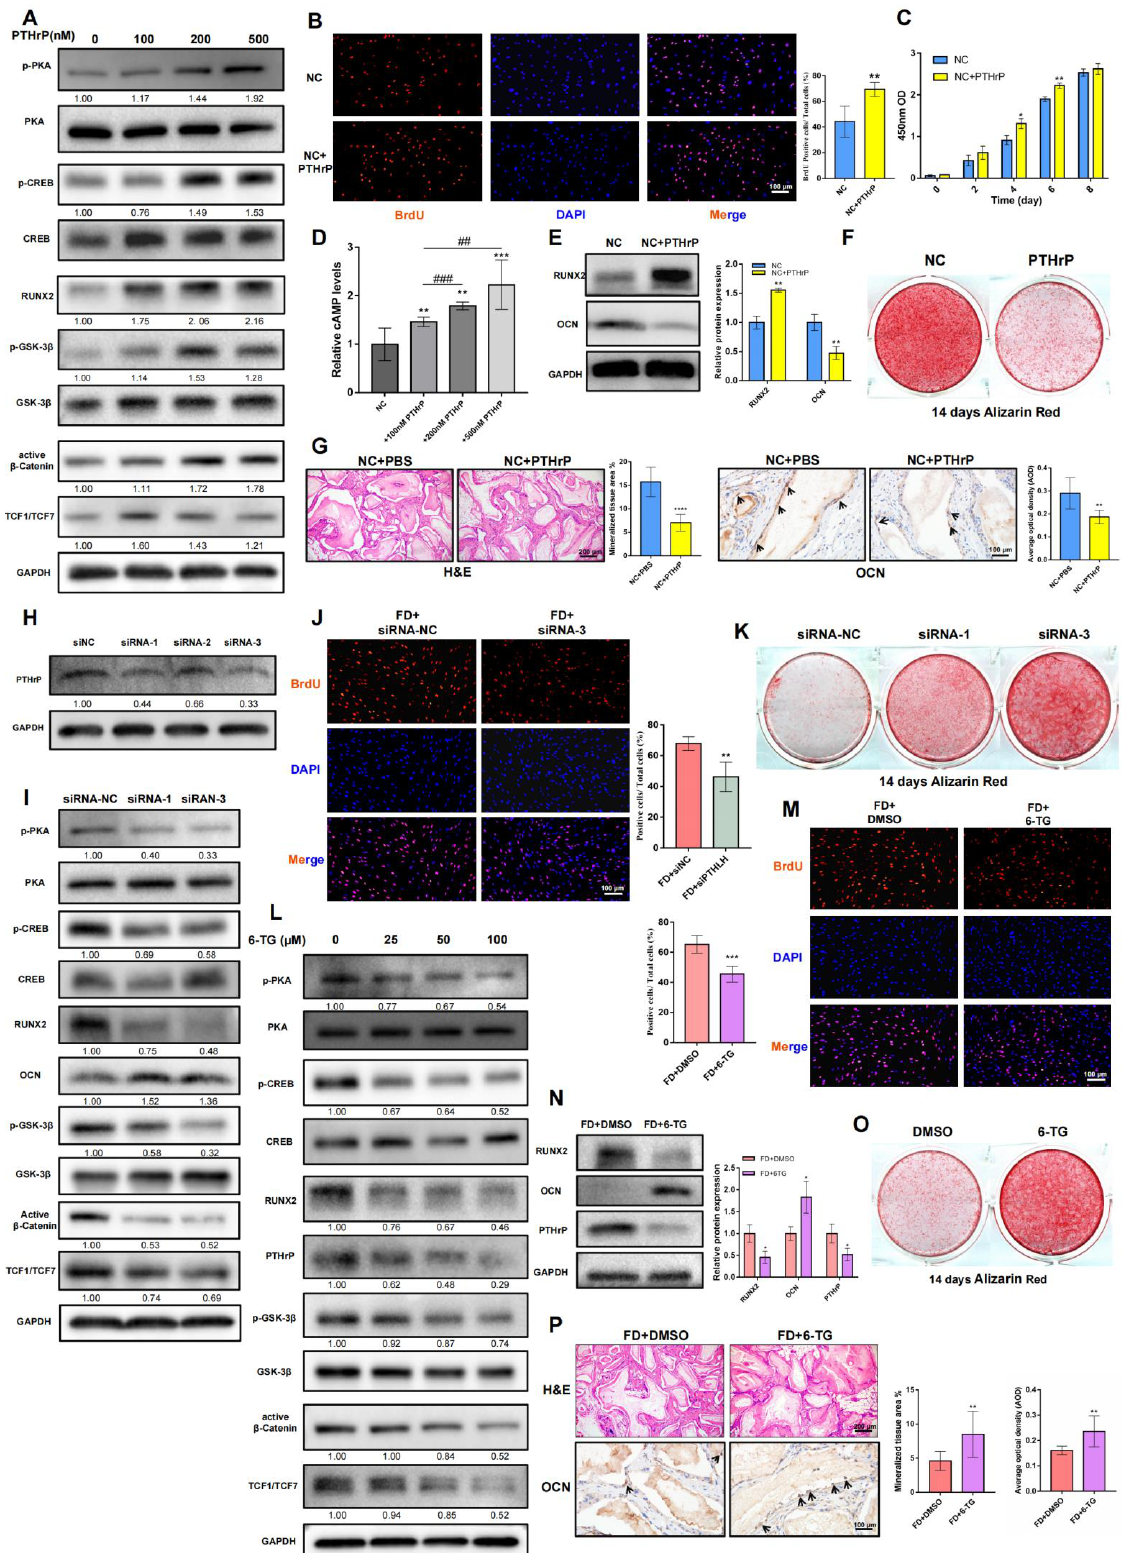
Figure 2. PTHrP promotes cell proliferation and inhibits osteogenesis. ( A ): WB analysis of NC BMSCs treated with PTHrP for 48 h at concentrations ranging from 0 to 500 nM concentration. Values represent the relative quantification of proteins at the indicated concentration. ( B ): Immunoflu- orescence staining of BrdU in NC BMSCs treated with PTHrP (200 nM) or PBS. ( C ): Proliferative